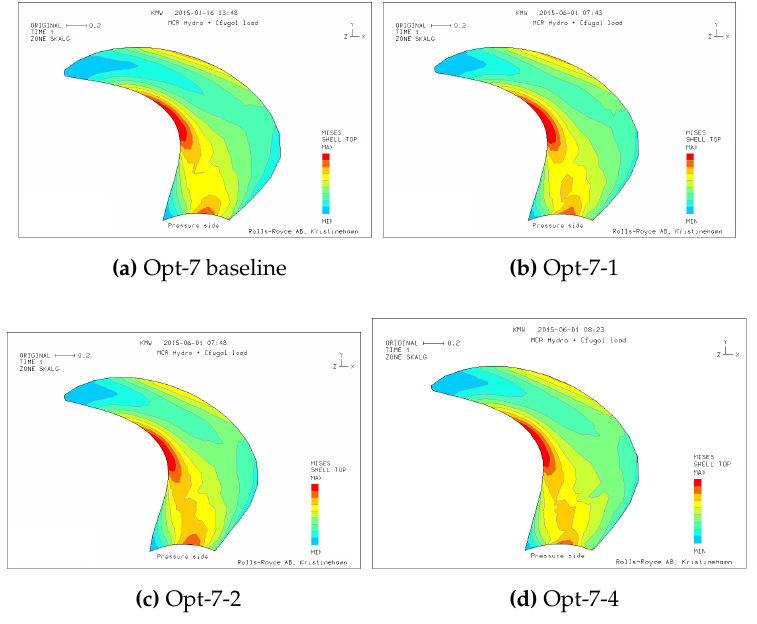
Figure 28. FEM simulation of hydrodynamic and centrifugal loads of baseline design and Pareto optimal solutions in Group 1. ( a ) Opt-7 baseline; ( b ) Opt-7-1; ( c ) Opt-7-2; ( d )